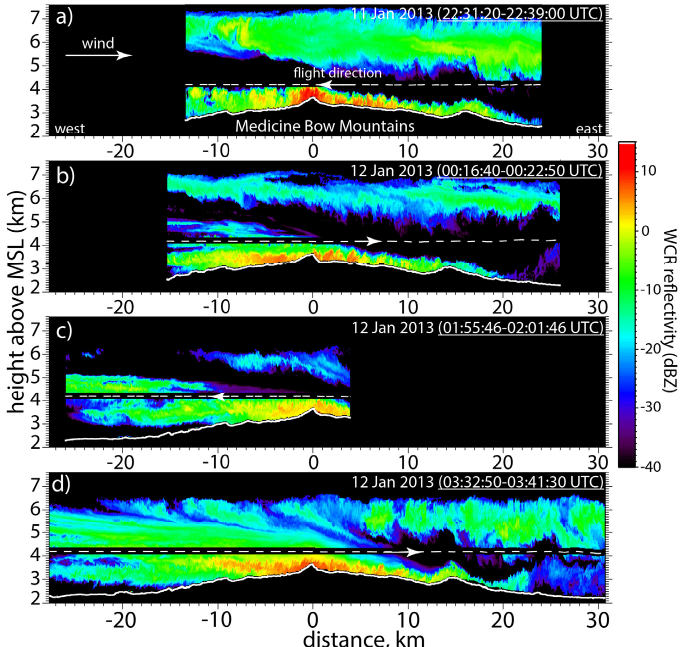
Figure 8. WCR-measured radar reflectivity for the four along-wind transects over the MBM flown over a five-hour period starting, in panel ( a ), at 22:30 UTC on 11 January 2013. The actual flight times are shown in the plots. The dashed line and arrow in all panels show the flight level and flight direction, respectively. The black belt centered at flight level is the radar blind zone. Distance 0 km in all panels corresponds with the crest of the MBM and the largest distance from panel ( d ) is kept in all panels. Shallow, stratiform clouds formed upwind of the MBM, producing light snowfall mainly over the crest (Figure 8). Snowfall extended into the lee, close to the ground. The somewhat cumuliform echoes in the lee, near the surface, are attributed to intense turbulence, as will be shown below. The echo strength and depth decreased with distance from the crest and sublimating falling snow likely transitioned to blowing snow further leeward, although WCR data do not allow for a distinction between the two types of snow. A cirrostratus layer aloft, likely advected from the south (Figure 3b), remained decoupled from the shallow orographic cloud (Figure 8). It weakened from the first to the third WCR transect. In the last WCR transect a new cirrus layer, advected from the west and merged with the low-level cloud, was drawn into the plunging flow over the MBM (Figure 8d).